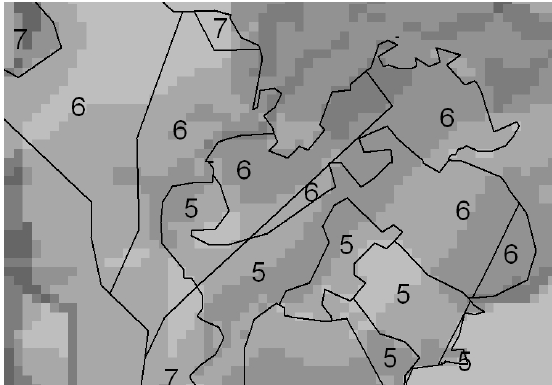
Figure 4. Example of zonal statics function: for each landscape unit (outlined in black) the label indicates the maximum scores of all the cells that fall inside it.